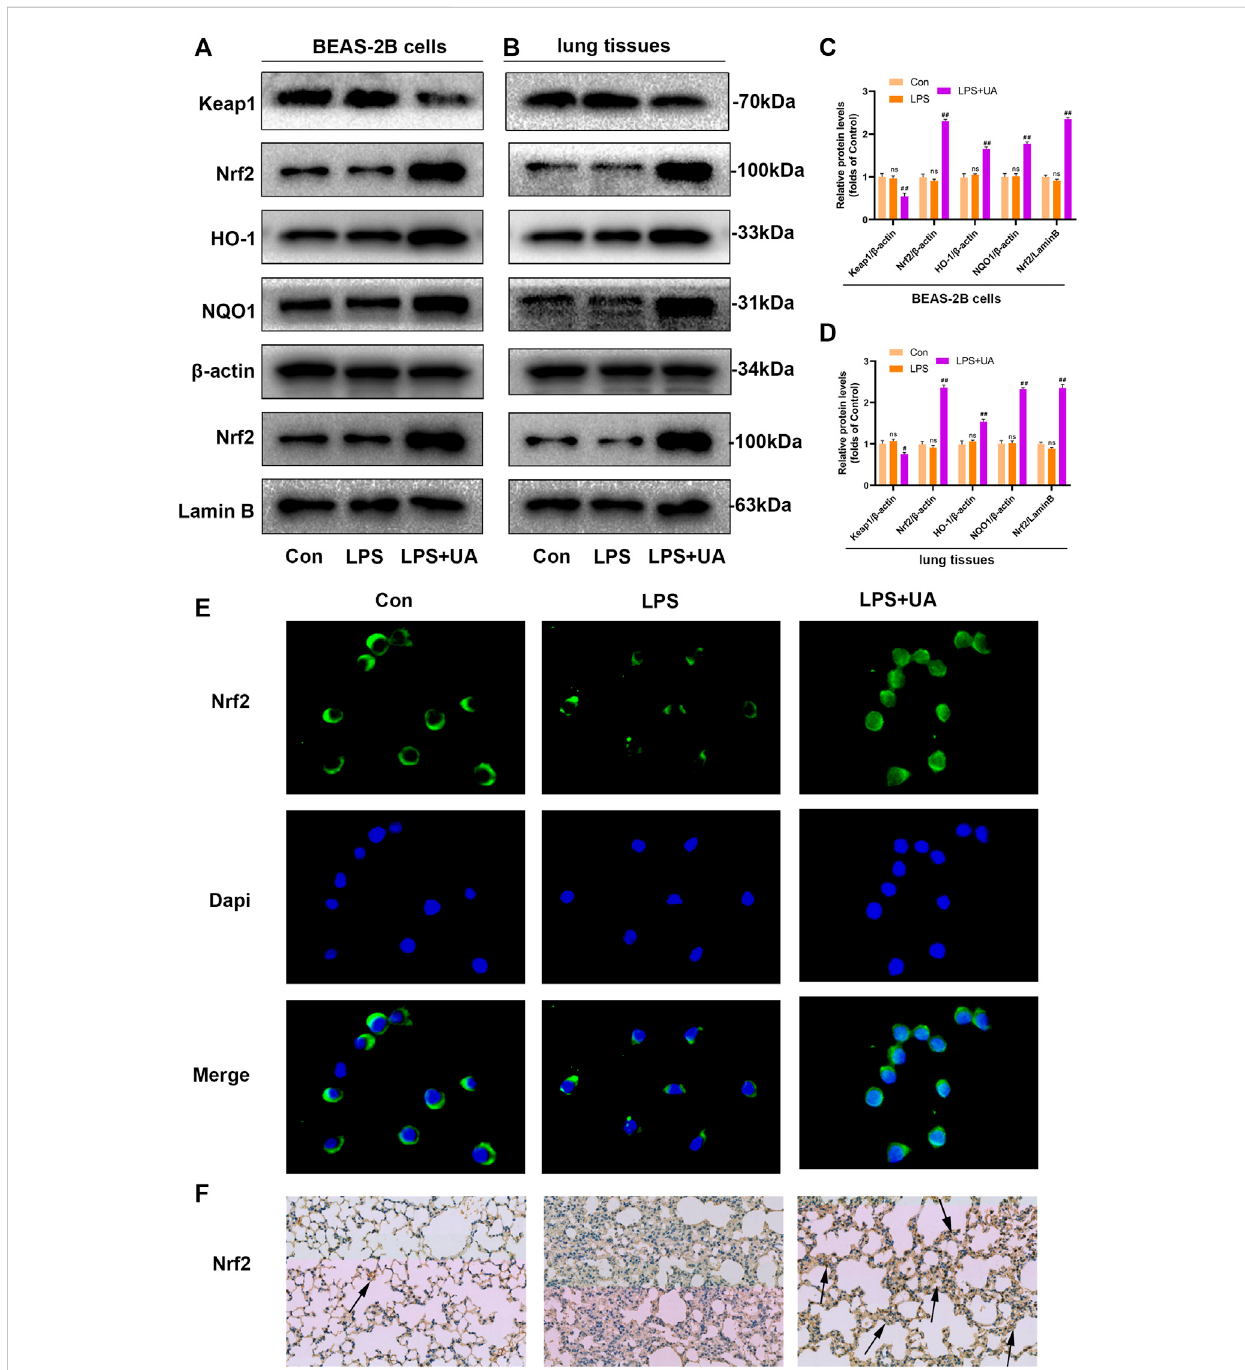
FIGURE 5 UrolithinA(UA)increasedNrf2expressioninLPS-mediatedBEAS-2BcellsandALImodels. (A,C) Quanti fi cationofKeap1,Nrf2,HO1,andNQO1levels in BEAS-2B cells. (B,D) Quanti fi cation of Keap1, Nrf2, HO1, and NQO1 levels within lung tissues. (E) Representative immuno fl uorescence images showed Nrf2 in BEAS-2B cells. (F) Typical IHC images showed the Nrf2 in lung tissues. The results were represented by mean ± SD. ## p < 0.01 and ns in comparison to LPS and control groups,